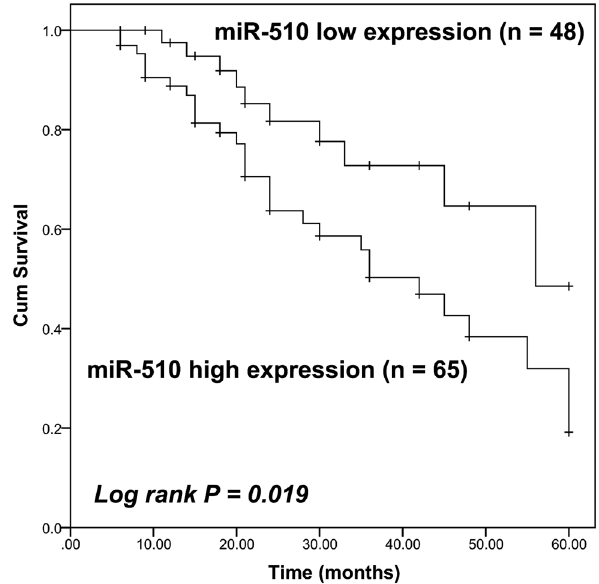
Figure 2: Kaplan – Meier curve of colon cancer patients with di ff erent miR - 510 expression levels. Colon patients were divided into the high miR - 510 expression group and the low miR - 510 expression group according to the mean value of the miR - 510 expression in colon cancer tissues. Patients with high miR - 510 expression levels had a poorer prognosis than that of patients with low miR - 510 expression levels ( Log - rank P = 0.019 )